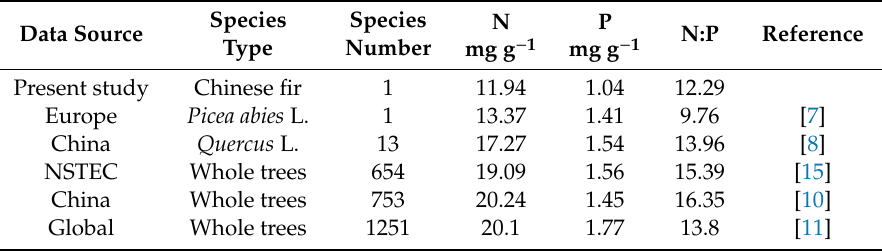
Table 3. Leaf N and P concentrations and N:P ratio for Chinese fir in the present study and flora in Europe, North–South Transect of Eastern China (NSTEC), China, and